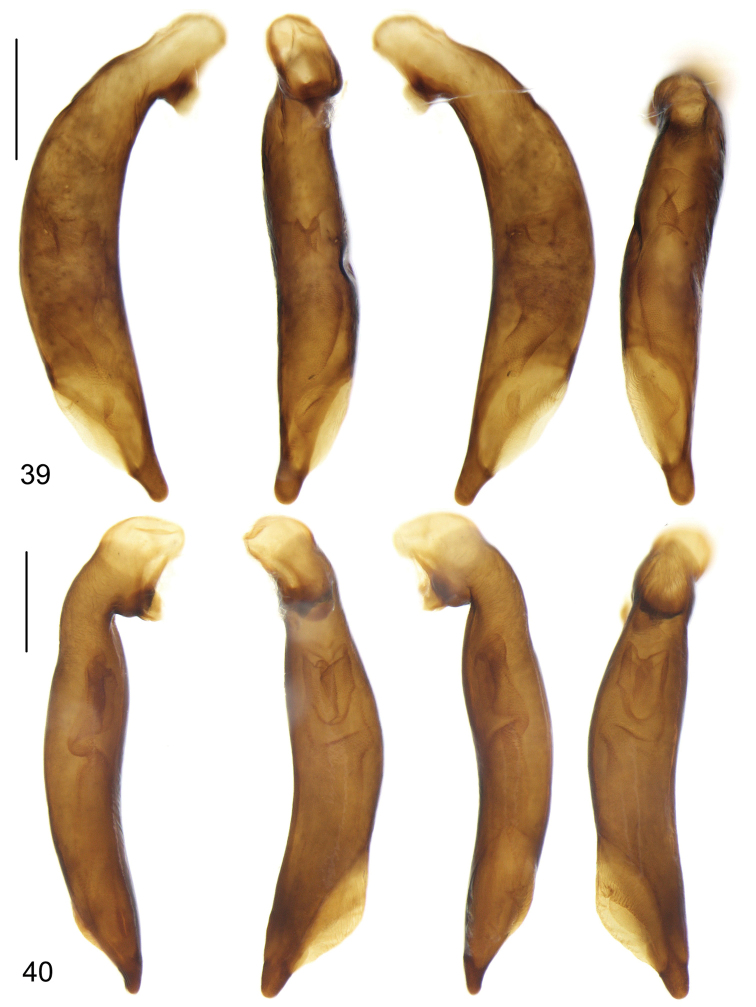
Median lobe of aedeagus, right-lateral, ventral, left-lateral, dorsal views 39
P.
ornatus
formosanus Dupuis, Taiwan (Miaoli) 40
P.
amplus Andrewes, Myanmar (Putao). Scale bars: 0.5 mm.